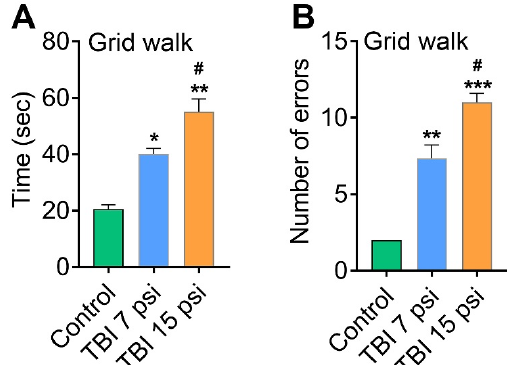
Figure 3. TBI causes sensorimotor deficits. Behavioral tests conducted at 8 DPI to analyze the effect of mild and moderate TBI on sensory and motor function. ( A , B ) Grid ‐ walk analysis demonstrated that both 7 and 15 psi injured mice made more time to finish the grid walk ( A ) with more number of errors ( B ) than control animals. Values are mean ± SEM; n = 6. * p < 0.05, ** p < 0.01, *** p < 0.001 versus uninjured control; # p < 0.05 versus 7 psi injury.